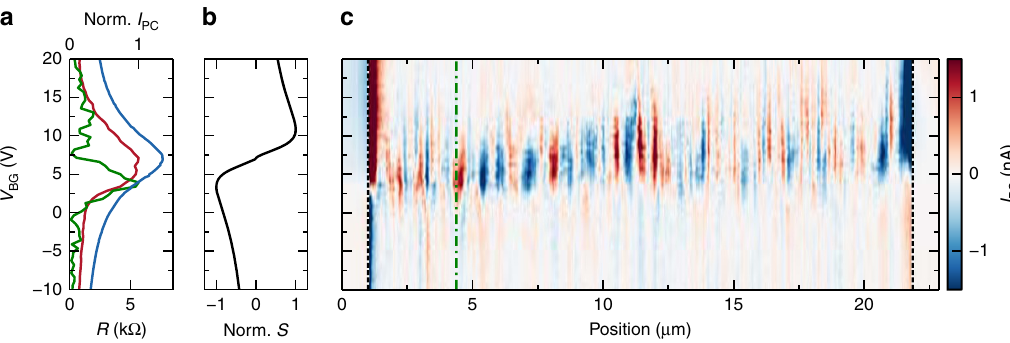
Figure 4 | Dependence of photocurrent profiles on backgate voltage reveals doping inhomogeneities. ( a ) Backgate dependence of the resistance of the device measured simultaneously to the photocurrent in blue. The red curve shows the normalized root mean square of the photocurrent across the device. The green curve shows a single normalized photocurrent backgate trace, corresponding to the green dashed dotted line in c . ( b ) Backgate dependent Seebeck coefficient of graphene, calculated from the gate dependent resistance in a using the Mott formula 52 . ( c ) Backgate dependence of the photocurrent across the device. Graphene is between the black dashed lines, which indicate the edges of the metal contacts.